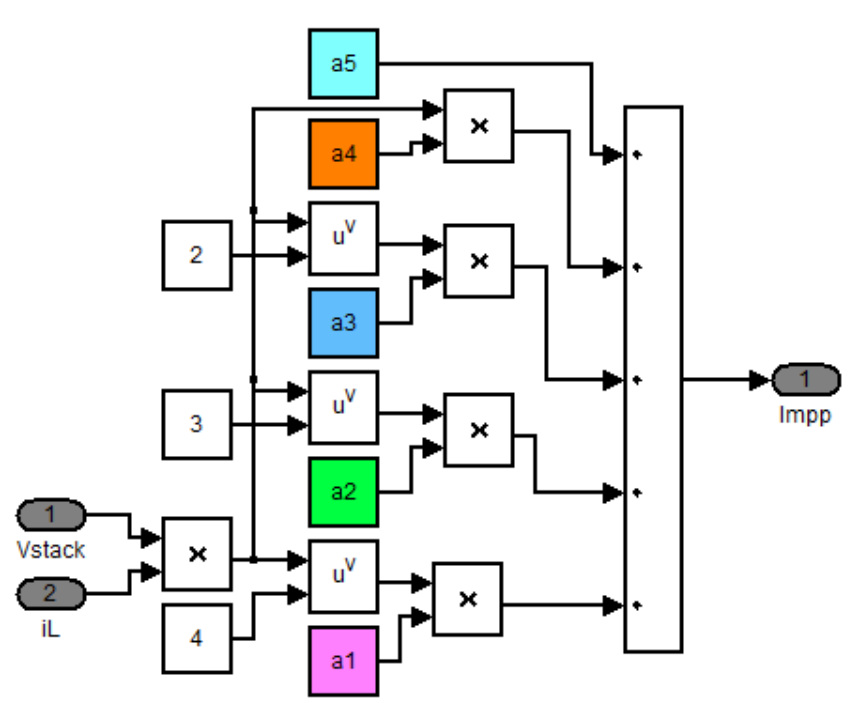
Figure 8. Synoptic diagram of the maximum power point tracking